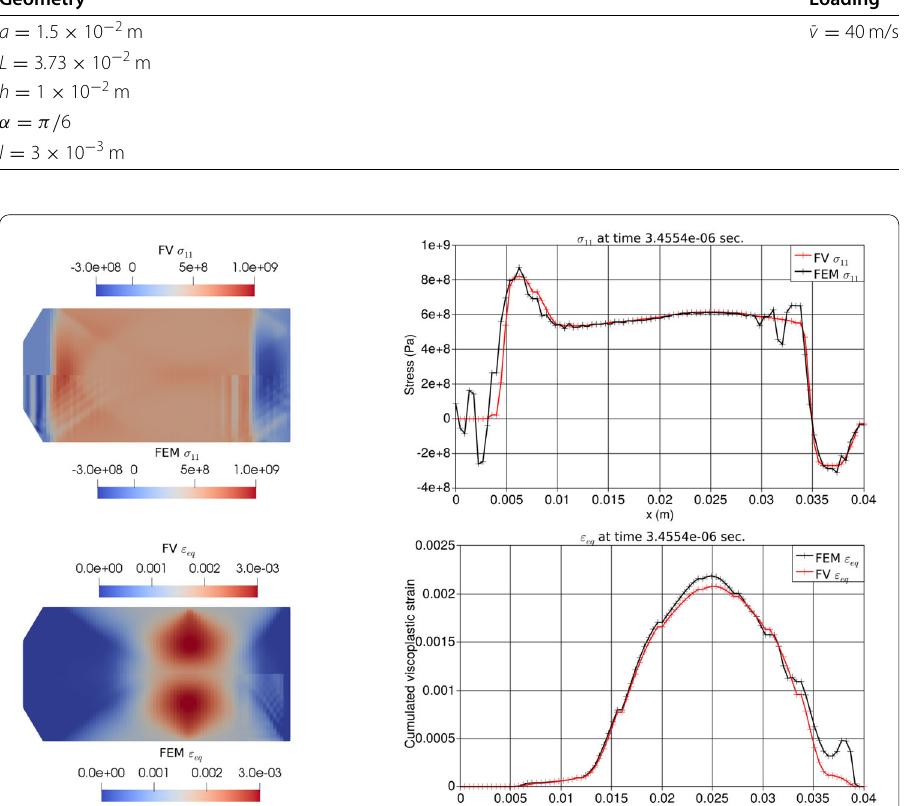
while the viscoplastic strains are close for both numerical solutions and show a conical spread pattern due to the plane of symmetry. Then, the left front of the tensile wave is reflected both on the notch and left plane of symmetry, which leads the normal stress σ 11 to double on the symmetry line and to concentrate at the notch corner. After few waves interactions, Fig. 17 shows viscoplastic strains which have much increased at the notch corners, so does for the normal stress which shows shearing pattern due to multiple